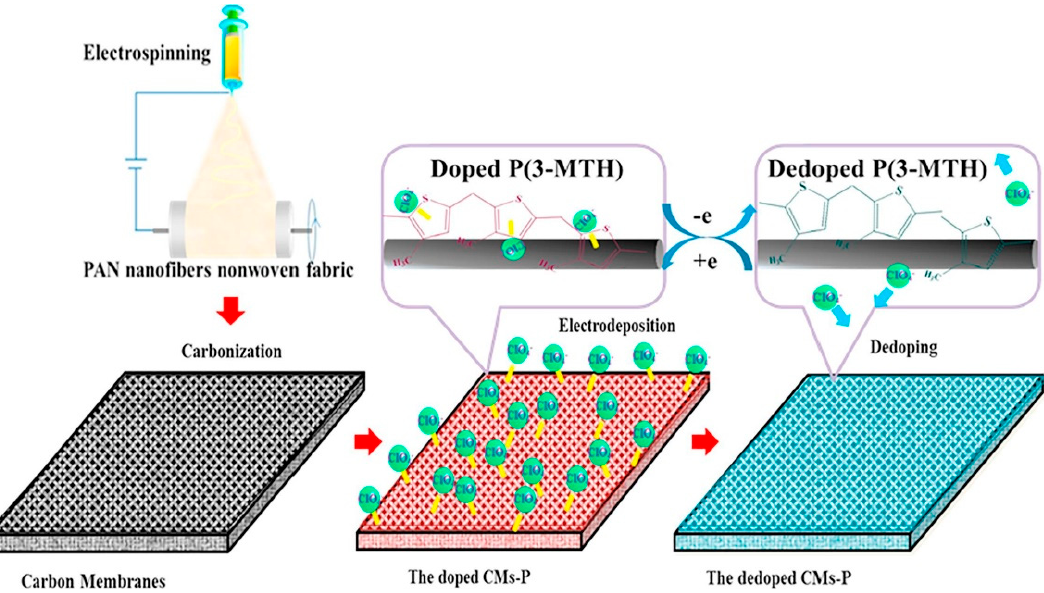
Figure 9. The schematic of CMs-P fabrication process. Reprint with permission from Ref. [81]. Copyright 2020, Elsevier. Table 3. Summary of smart responsive Janus materials with asymmetric wettability for oil–water separation.